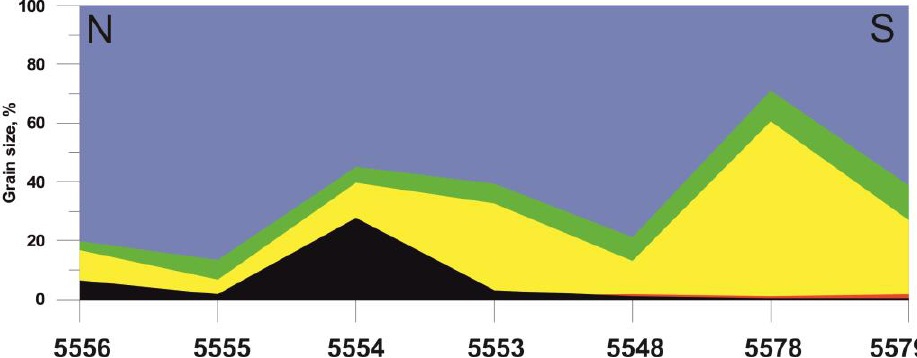
Figure 4. Grain-size composition in surface sediments from the Kola Transect along the.33°40’ E, the Barents Sea. Symbols see in Figure 2.